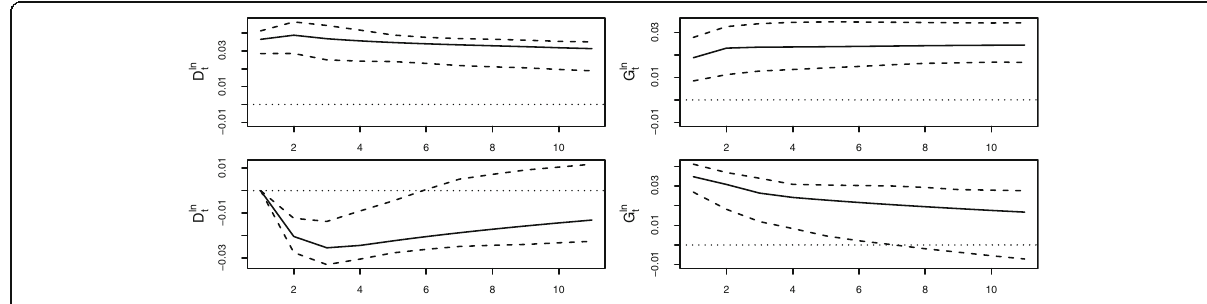
Fig. 1 Orthogonal impulse response functions with 95% bootstrap CI for boom phases. Top: from D ln